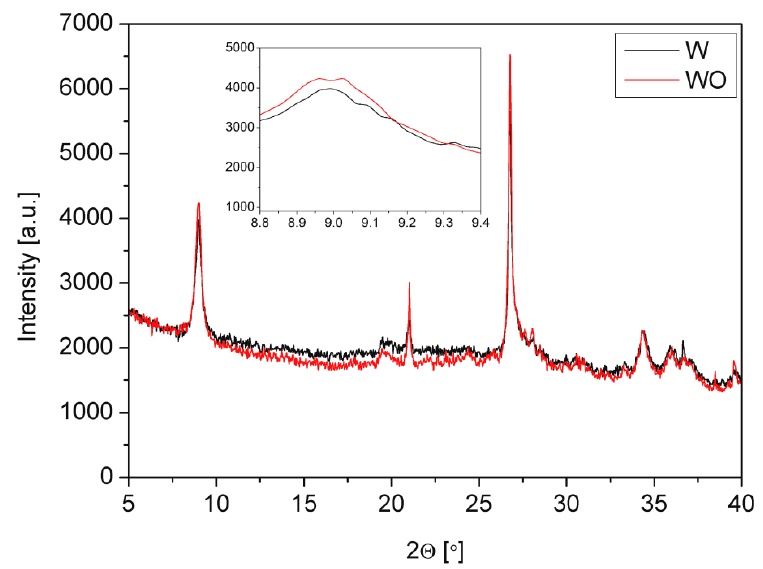
Figure 2. XRD patterns of thermally expanded vermiculite (W) and vermiculite additionally treated grade with H 2 O 2 (WO).